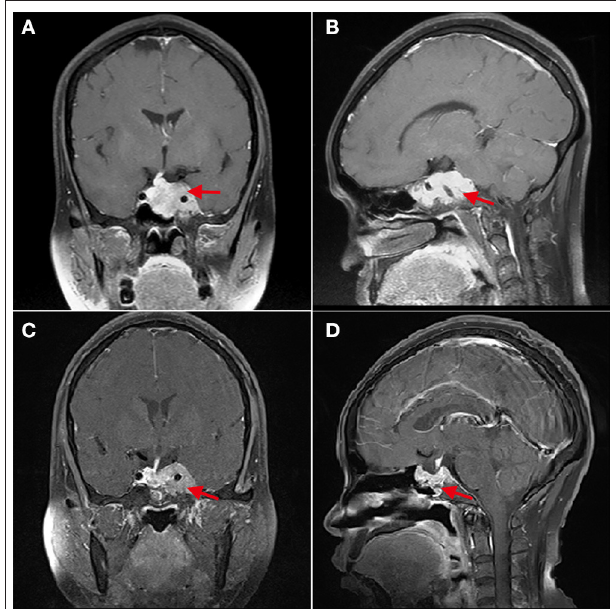
FIGURE 2 | The cavernous sinus invasion limits the gross-total resection of GPA. (A,B) Patient 4, (A) shows that the left cavernous sinus is filled with tumor, and the internal carotid artery is surrounded (red arrow); (B) shows that the sphenoid sinus is also filled with tumor tissue. (C,D) Three months after operation, (C) shows the residual tumor in the left cavernous sinus (red